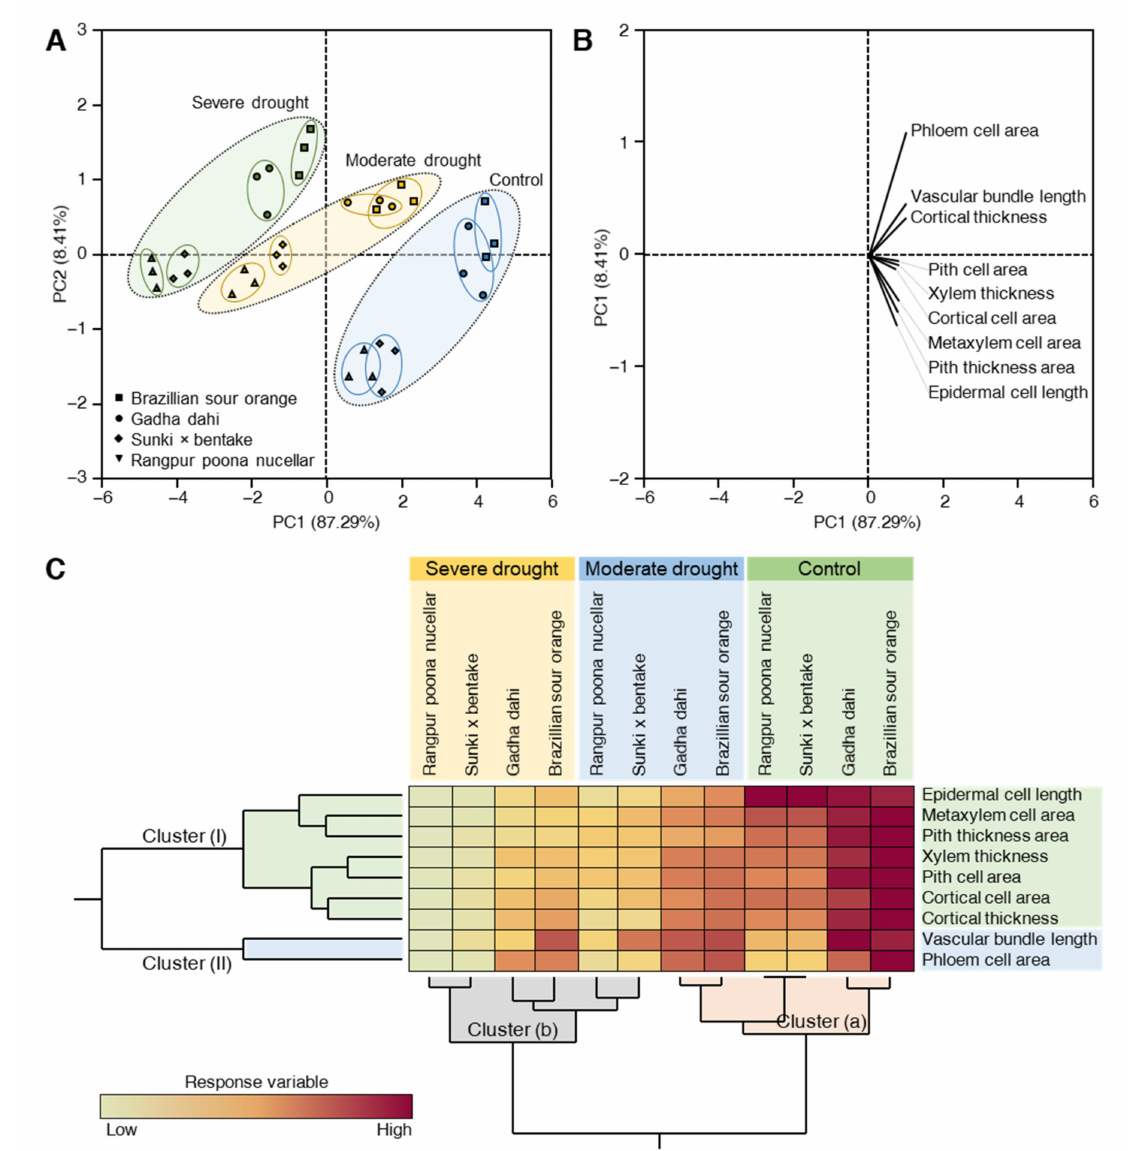
Figure 5. Principal component analysis (PCA) and two-way hierarchical cluster analysis (HCA) of individual stem anatomical features of two highly tolerant (Brazilian sour orange and Gadha dahi) and two highly sensitive genotypes (Rangpur Poona nucellar and Sunki × bentake) under three water regimes. ( A ) PCA-associated scatter plots, ( B ) PCA- associated loading plots, and ( C ) two-way HCA. Variations in the dependent variables among studied treatments are visualized as a heat map. Rows correspond to dependent variables, whereas columns correspond to different treatments. Low numerical values are light-yellow-colored, while high numerical values are colored dark red (see the scale at the right bottom corner of the heat